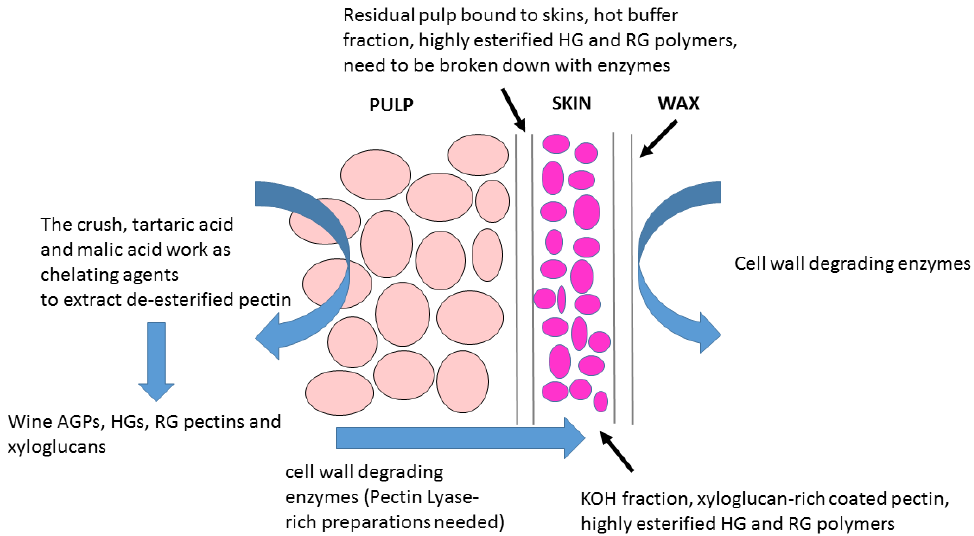
Figure 4. A simplified model of the wine grape cell wall showing the major tissue layers and the role of enzymes in maceration during